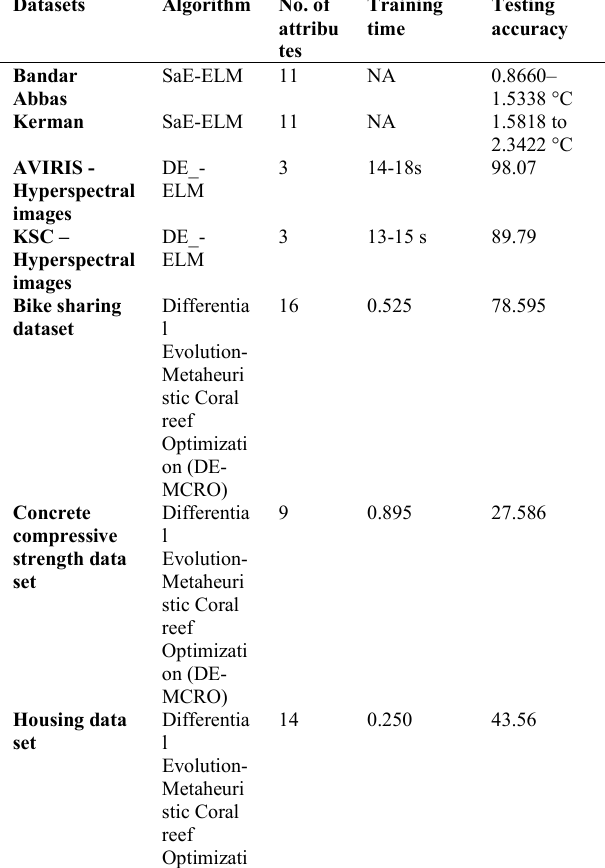
Table 3. Algorithm accuracy of the suggested techniques in the aspect of datasets [36-41]